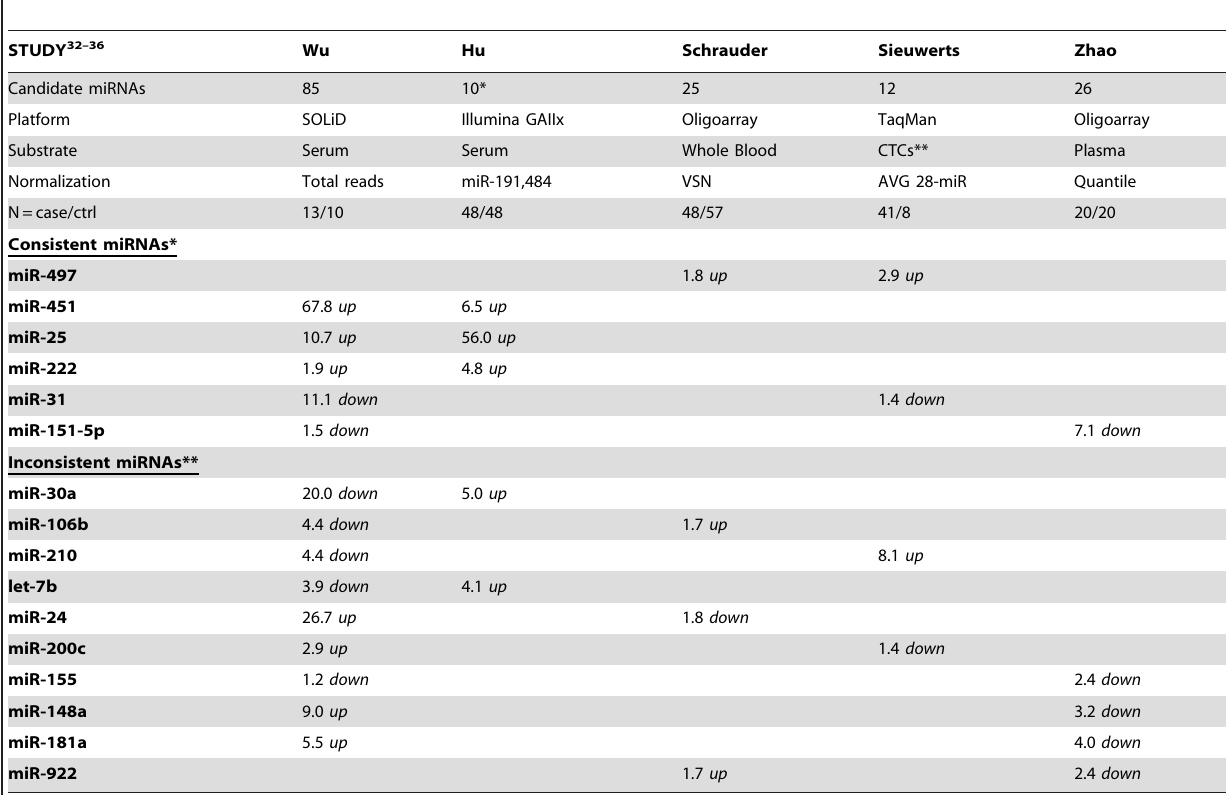
Table 2. Genome-Wide Circulating miRNA Profiling Studies in Breast